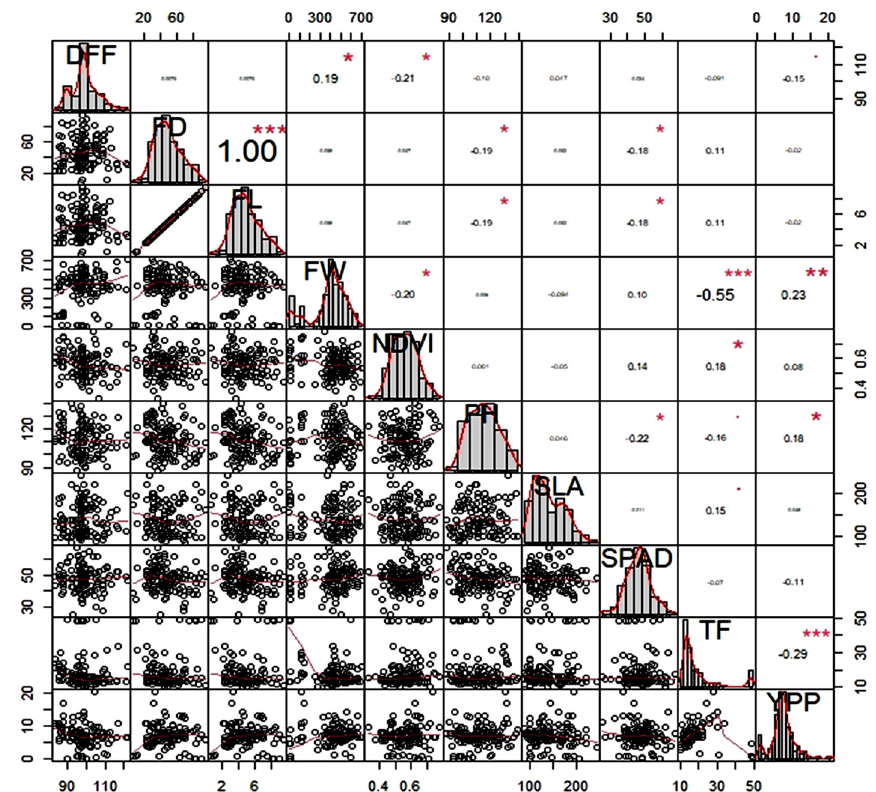
Figure 3. Correlation matrix, scatter plot and phenotypic frequency distribution of traits; * p <= 0.05; ** p <= 0.01; *** p > 0.001; DFF = Days to first flowering (day), FD = Fruit diameter (cm), FL = Fruit length (cm), FW = Fruit weight (g), YPP =Yield plant -1 (kg), NDVI = Normalized difference vegetation index, PH = Plant height (cm), SLA = Single leaf area (cm 2 ), SPAD = Soil plant analyses development, TF = Total number of fruits.